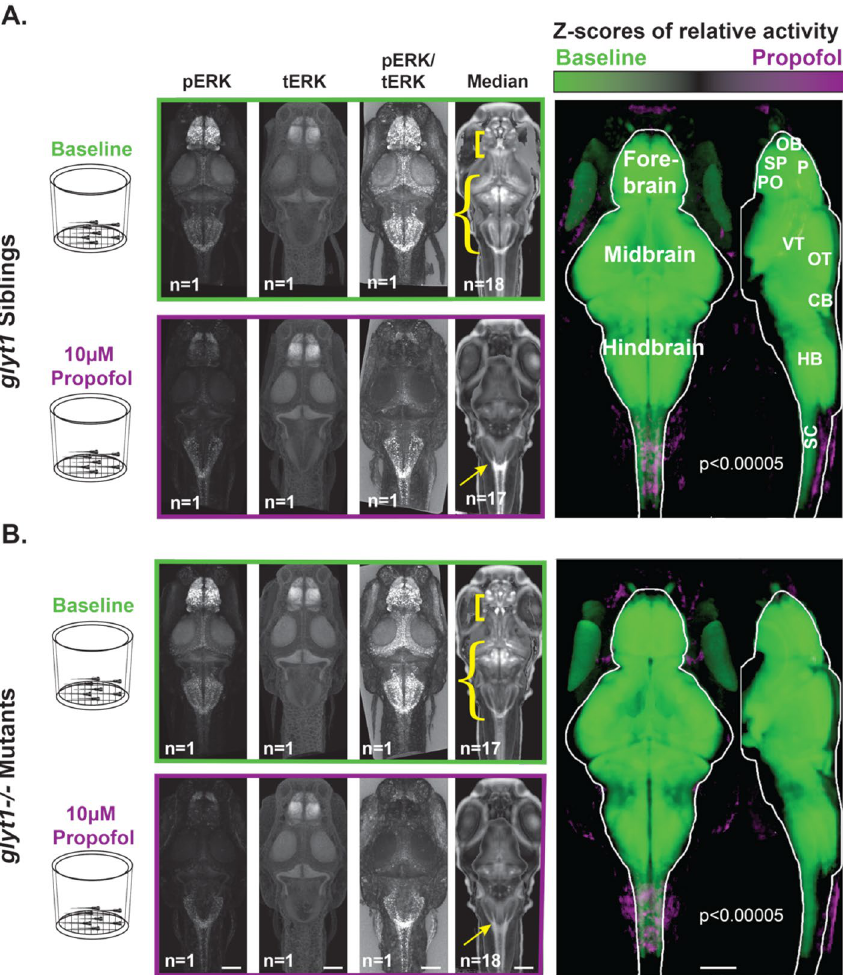
Figure 5. Brain-wide activity in both glyt1−/− mutants and wild type siblings is significantly reduced by exposure to propofol. Four batches of sixteen to eighteen, six-day-old larvae were placed in baskets (diagramed to the left) to enable easy transfer of larvae from system water to 10 µM propofol solutions. Half contained glyt1 siblings ( A ) and the other half glyt1−/− mutants ( B ). Larvae from each treatment were fixed and stained with pERK and tERK antibodies and z-stacks of the brain were captured on a confocal microscope. Images boxed in green correspond to baseline conditions while images boxed in purple correspond to exposure to 10 µM propofol for twenty minutes. Images show standard deviation projections of pERK, tERK, pERK/tERK, and median values. To compare activity between baseline and propofol treatments, voxels with more intense pERK/tERK at a p < 0.00005 threshold under baseline conditions are shown in green while voxels with more intense pERK/tERK in propofol are shown in purple for glyt1 siblings ( A ) and glyt1−/− mutants in ( B ). It is clear that both glyt1 siblings and glyt1−/− mutants have reduced activity at anesthetic doses of propofol as expected from their similar dose/response curves. Yellow brackets, curly brackets and arrows in median images highlight staining patterns that differ significantly between glyt1−/− mutants and their siblings. Under Baseline conditions, brackets point to a region encompassing the subpallium and preoptic that has more pronounced staining in the glyt1−/− mutants while curly brackets point to a region encompassing the optic tectum, cerebellum, and hindbrain that has more intense staining in the glyt1 siblings. Under propofol, arrows point to the area postrema region of the hindbrain that has more pronounced staining in glyt1 siblings. CB cerebellum, HB hindbrain, OB olfactory bulb, OT optic tectum, P pallium, PO preoptic, SC Spinal Cord, SP Sub-pallium, VT ventral tegmentum. Scale bars = 100